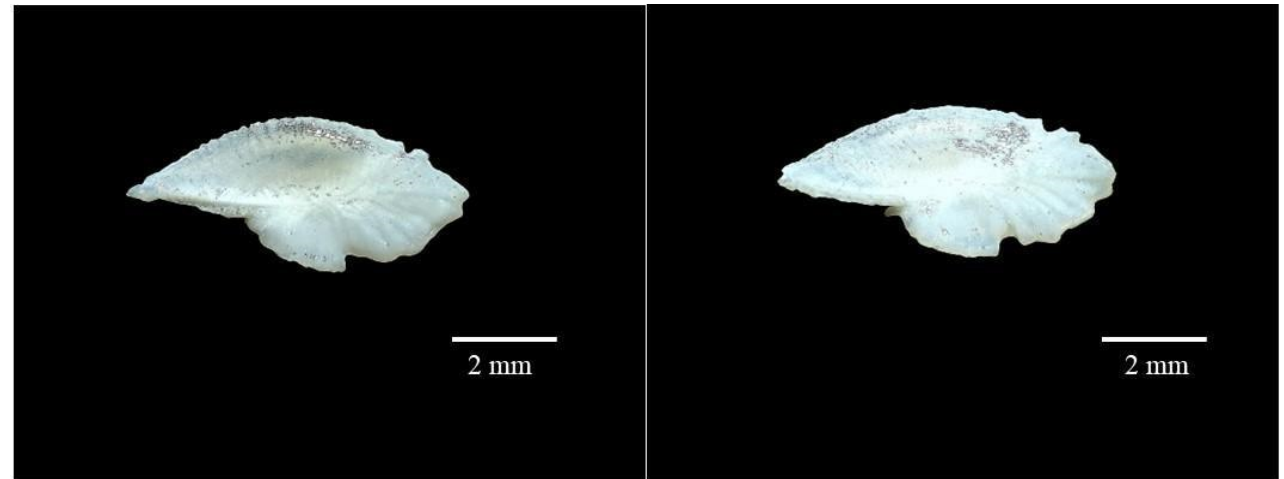
Figure 3. Representative sagittal otolith (right and non-sulcus side) images of D. kurroides collected in the Sibuyan Sea (left) and Sulu Sea (right) from February 2021 to July 2021. Table 3. Statistical relationships between D. kurroides otolith descriptors and fish total length.